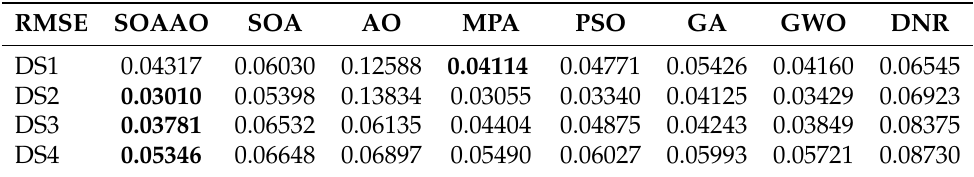
Table 3. RMSE results.